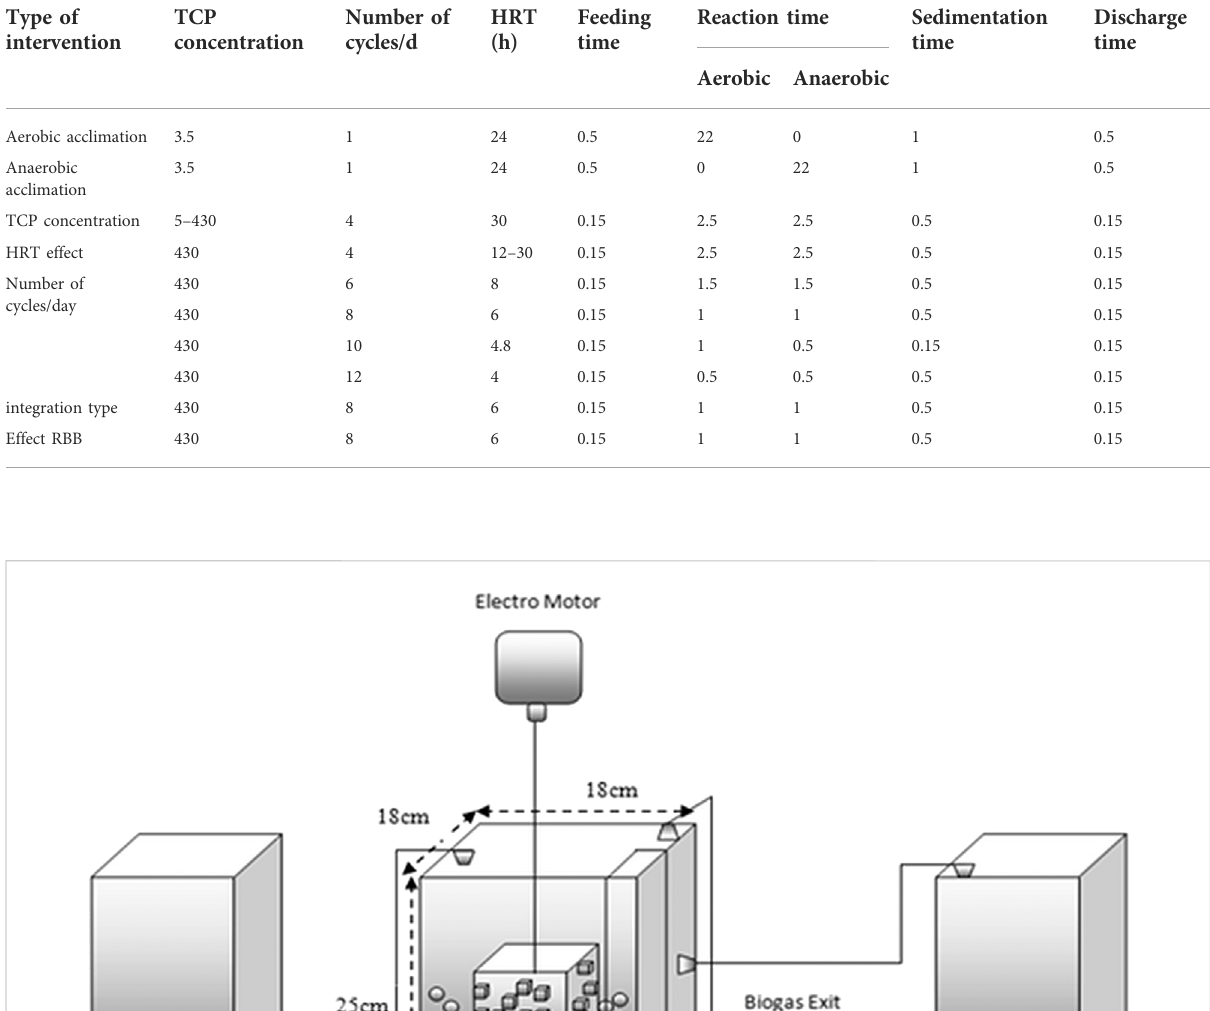
TABLE 1 Bioreactor operation schedule.